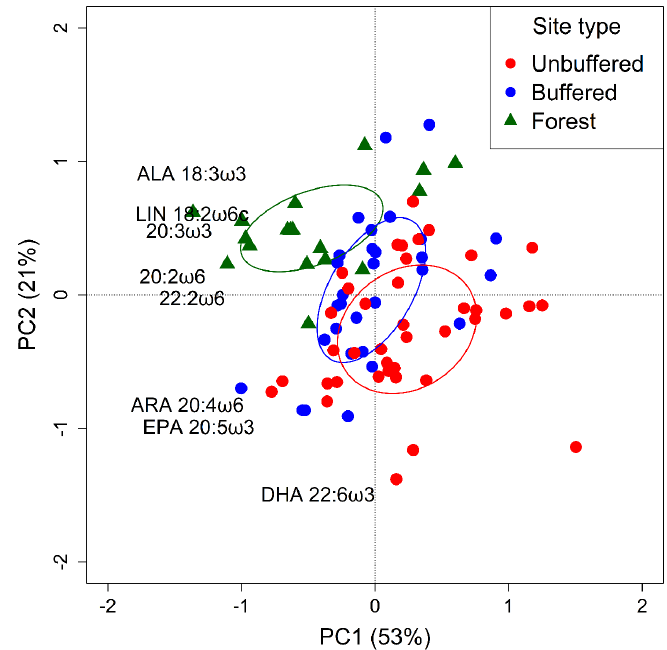
Figure 6. Principal components analysis (PCA) plot describing how spider samples varied